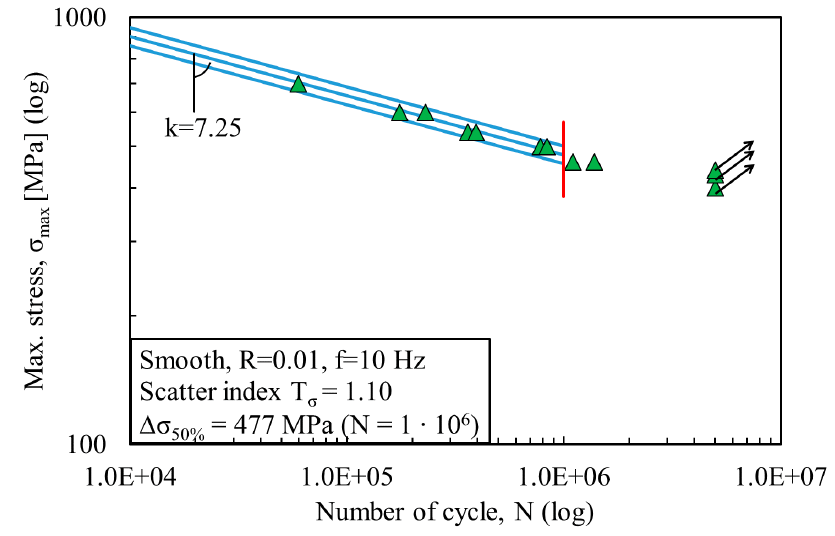
Figure 3. S-N fatigue data from LENS ® additively manufactured non-porous specimens.